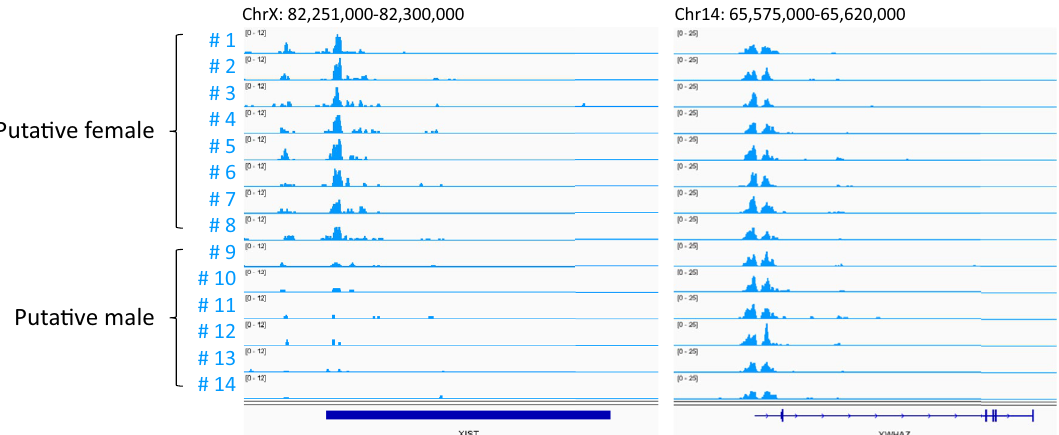
Figure 8. H3K4me3 modifications at the XIST locus in each embryo. The right panel shows an example of a gene with sex-independent H3K4me3 modifications, like many others, of YWHAZ